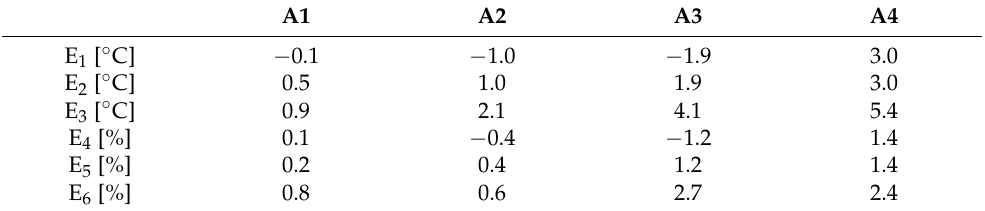
Table 5. Values of estimates E 1 –E 6 for temperatures (14)–(19) with heating process p2 in planes A1–A4. A1 A2 A3 A4 E 1 [ ◦ C] 0.5 − 0.1 − 1.0 0.6 0.5 0.2 1.0